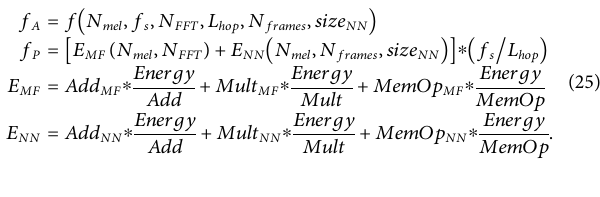
FIGURE 13 | Anomaly detection power bene fi ts from